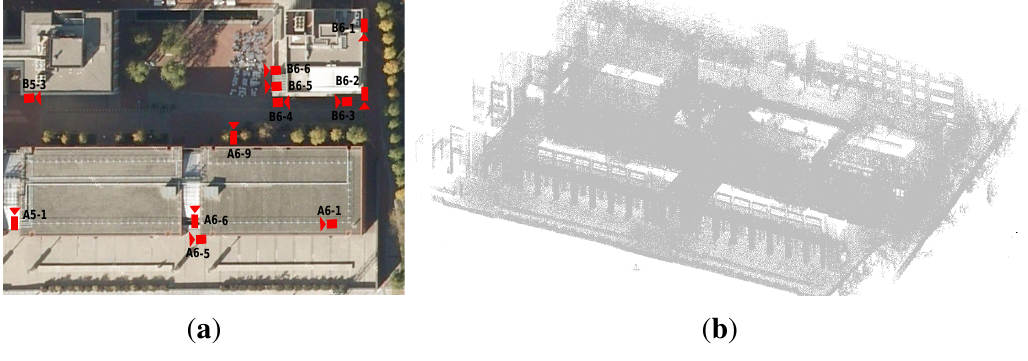
Figure 7. The Barcelona Robot Lab. ( a ) Aerial view of the camera distribution; and ( b ) the point cloud.